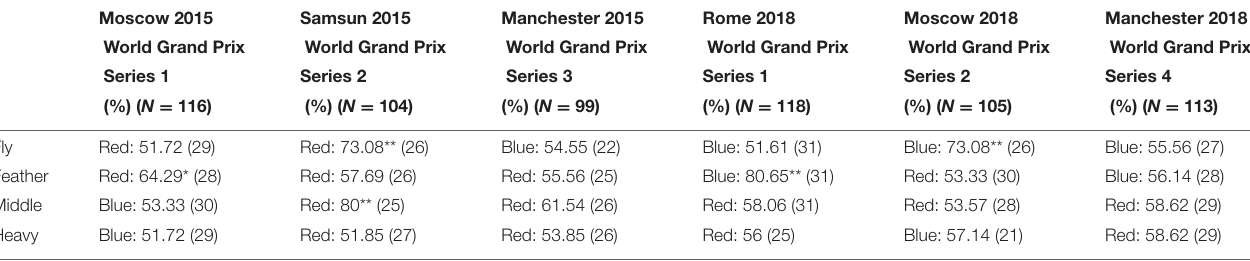
TABLE 4 | Percentage of matches won by female athletes according to their color protectors, edition, and weight